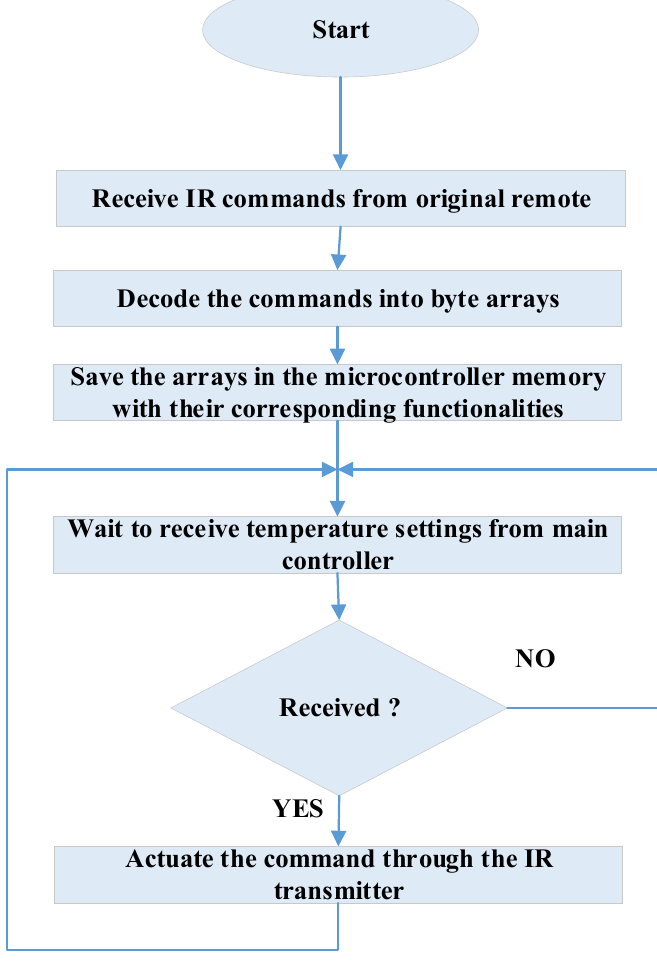
Figure 5. Operation of the IR remote control.